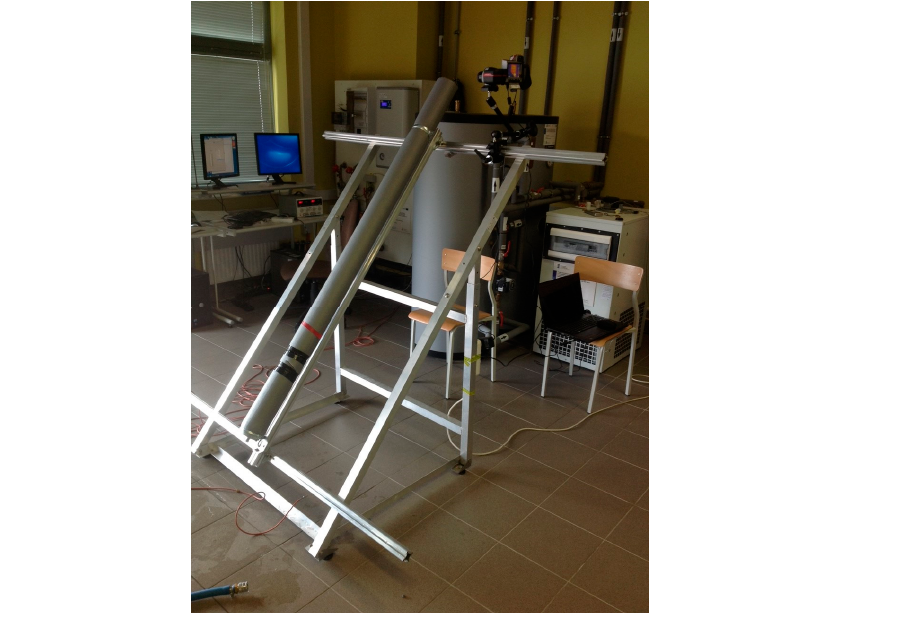
Figure 10. The heat transfer test stand.